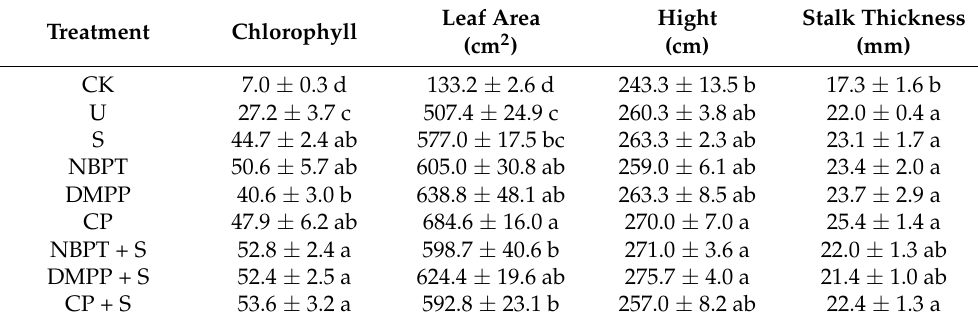
Different lowercase letters in the column mean a significant difference between treatments (Tukey test, p < 0.05). Treatments: CK: no N fertilizer; U: urea; S: urea + seaweed extracts; NBPT: urea + N-butyl